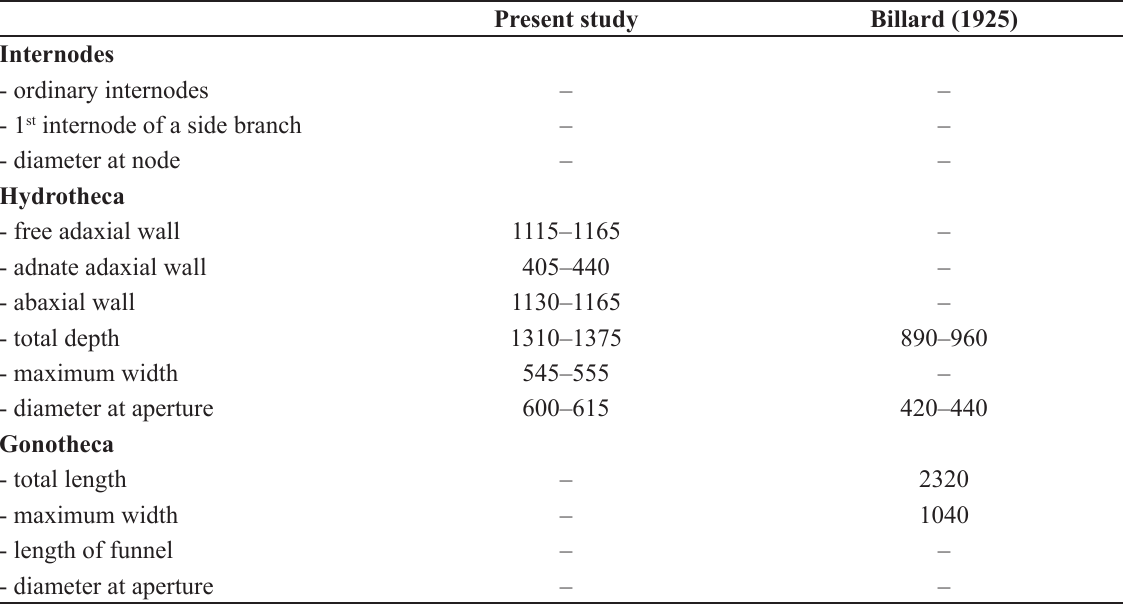
Table 12. Measurements of Symplectoscyphus cf. tropicus (Hartlaub, 1901), in